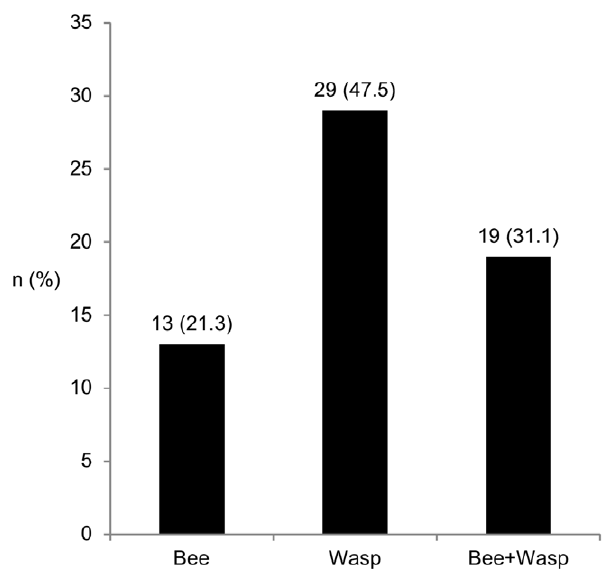
Figure 5. Frequency of sensitization to bee and/or vespid venom in the basophil activation test. n=61.